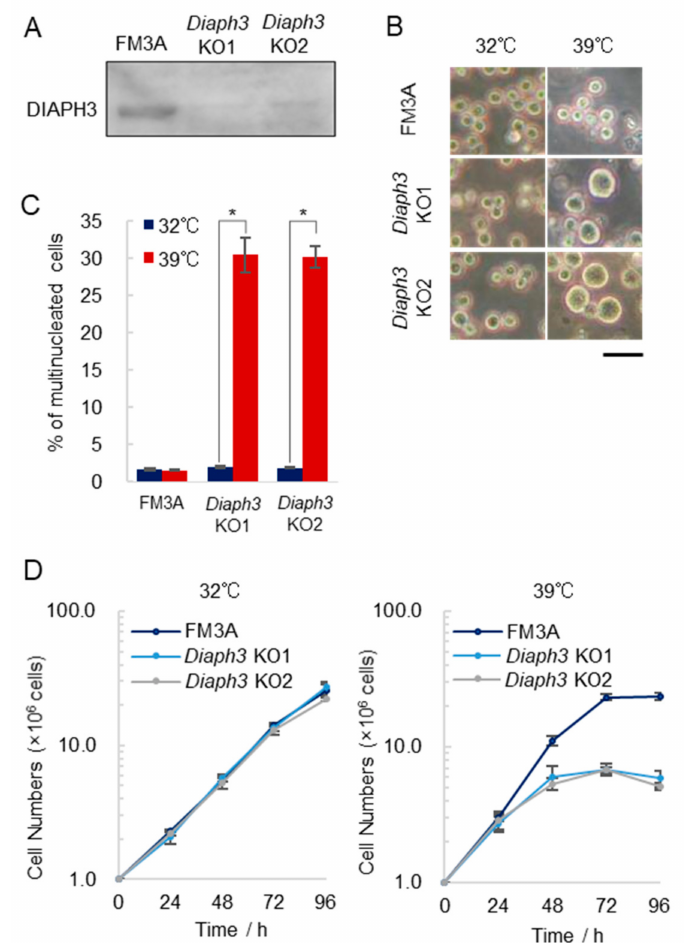
Figure 3. Diaph3 knockout cells are temperature-sensitive under high temperature conditions. ( A ) Diaph3 knockout FM3A cells ( Diaph3 KO1 and Diaph3 KO2) were established by the CRISPR-Cas9 system, and the expression of Diaph3 in the cells was examined by Western blotting. ( B ) Cell images: FM3A and Diaph3 KO cells were cultured at 32 or 39 ◦ C for 96 h under 5% CO 2 . The scale bar indicates 20 µ m. ( C ) FM3A and Diaph3 KO cells were cultured at 32 and 39 ◦ C for 24 h and subsequently stained with DAPI. More than 300 cells were measured and the percentage of multinucleated cells was calculated; (error bars: ± SEM); * p < 0.001 (Dunnett’s test); 32 vs. 39 ◦ C. ( D ) Growth curve analysis of FM3A and Diaph3 KO cells: Cells (1.0 × 10 6 ) were seeded and cultured at 32 or 39 ◦ C under 5 % CO 2 ; (error bars: ± SEM); * p < 0.001 (Student’s t-test); FM3A (39 ◦ C) vs. Diaph3 KO (39 ◦